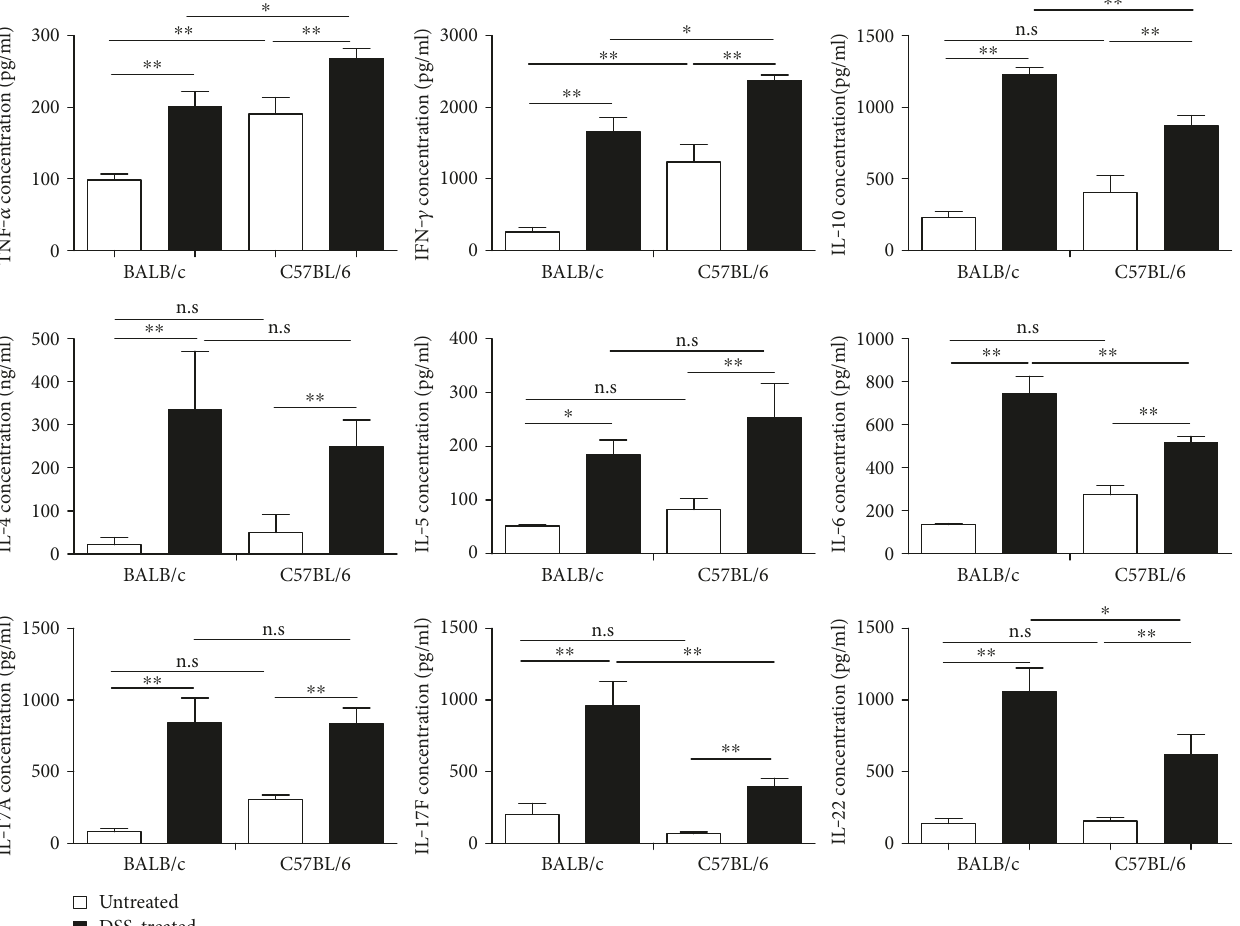
Figure 2: Cytokine production by T-LPLs in DSS-induced acute colitis model of BALB/c and C57BL/6 mice. Cytokine production in the supernatant of anti-CD3 ε -stimulated cultured LPLs was analyzed by ELISA. Data indicate mean ± SD obtained from two independent experiments, in triplicate each. The levels of IL-1b and IL-23 in colon tissues were below detection limit and thus not shown. Statistical di ff erences were evaluated by Student ’ s t -test. ∗ p < 0 05 ; ∗∗ p < 0 01